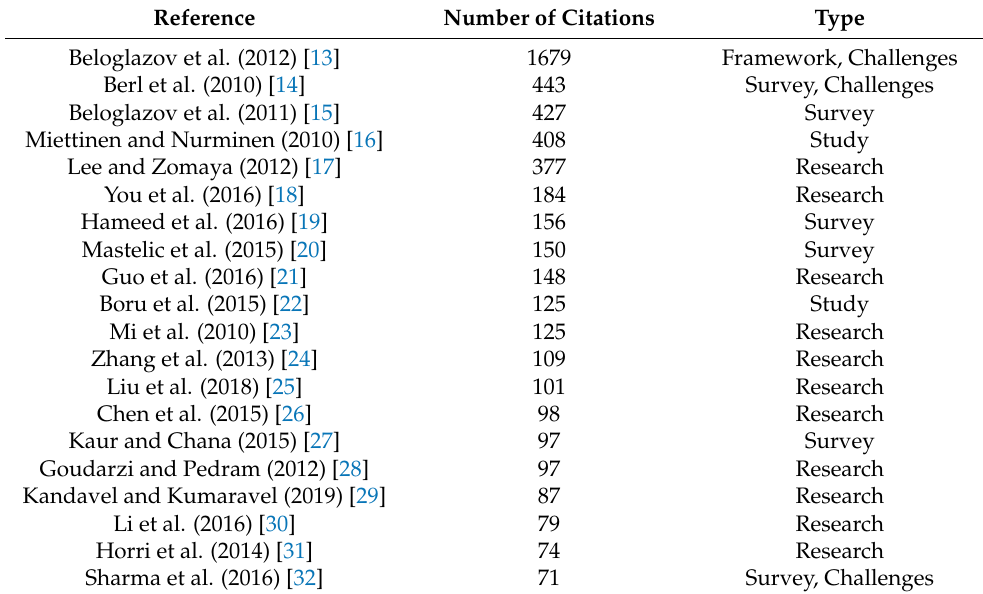
Table 2. Top 20 core references in the cloud computing energy efficiency research field (ranked by the number of